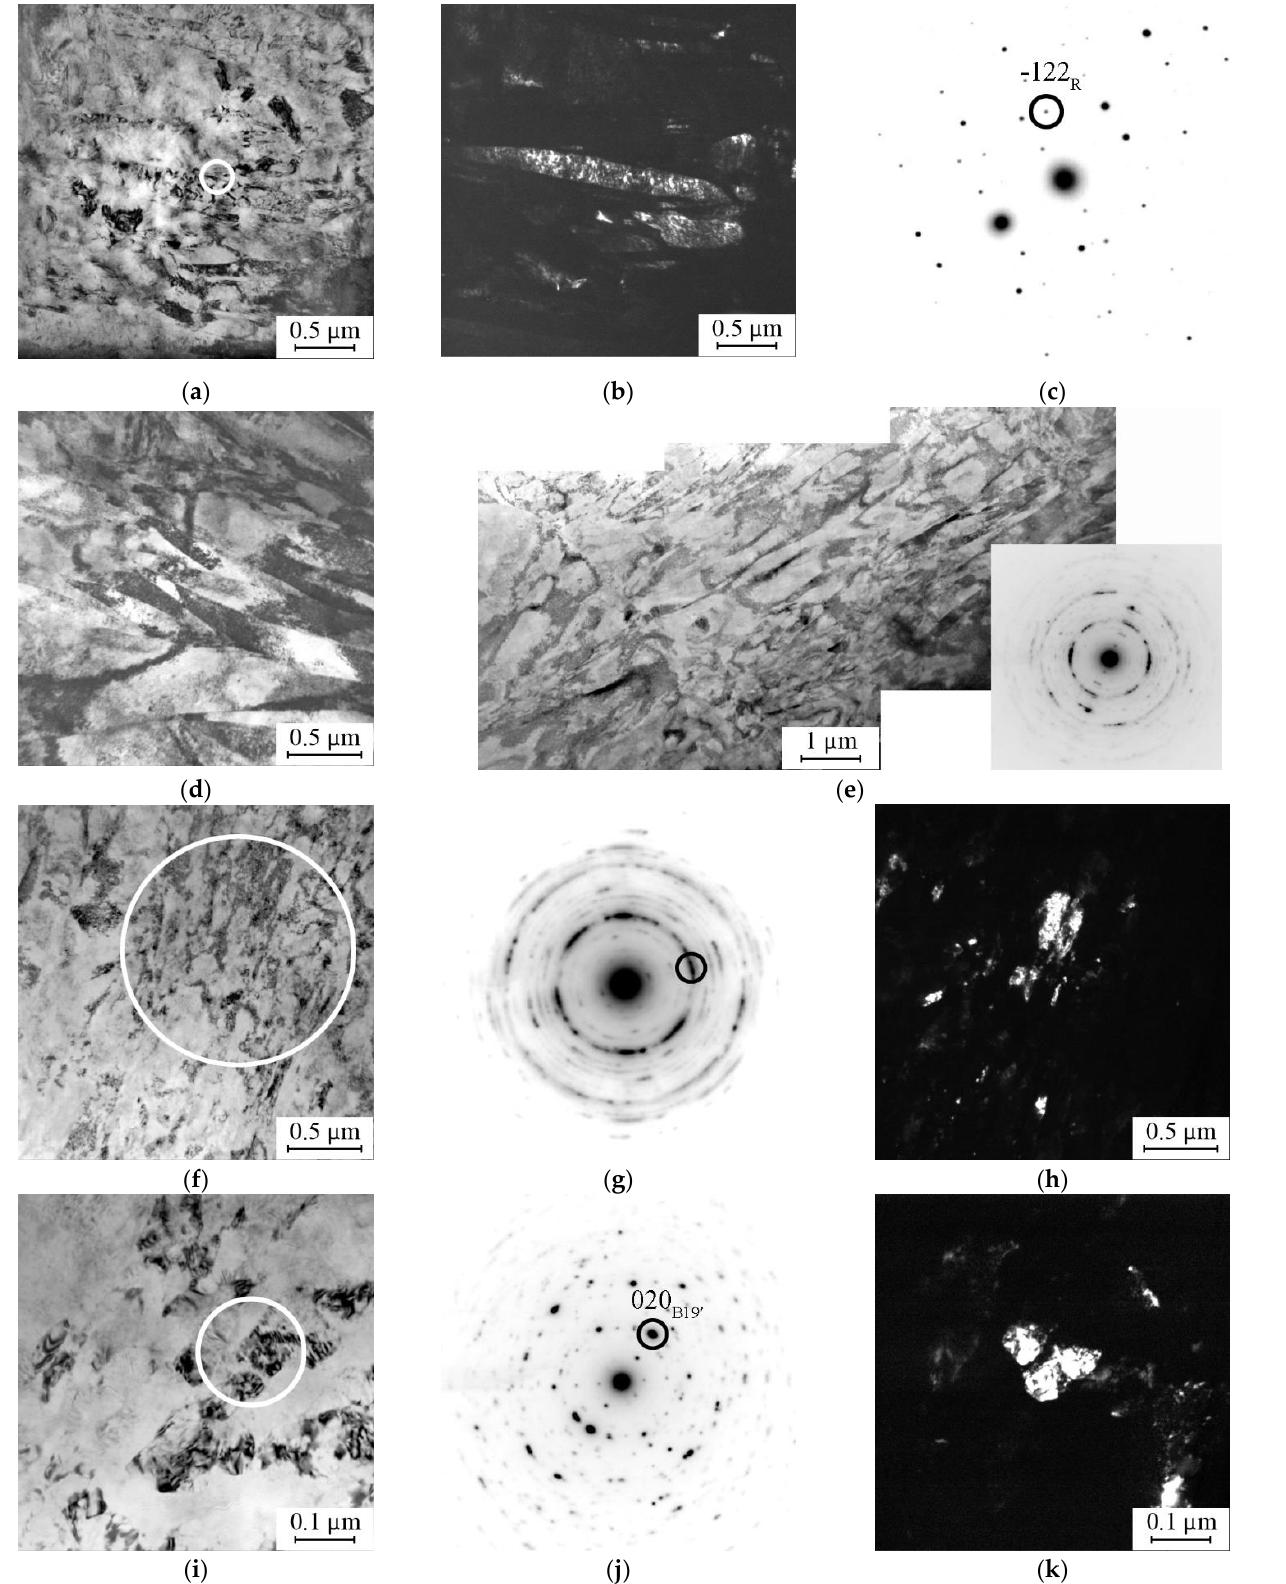
Figure 7. TEM images and diffraction patterns of Ti 49.8 Ni 50.2 before ( a – c ) and after abc pressing to e = 1.84 ( d ), e = 5.4 ( e ), and e = 9.55 ( f – k ).